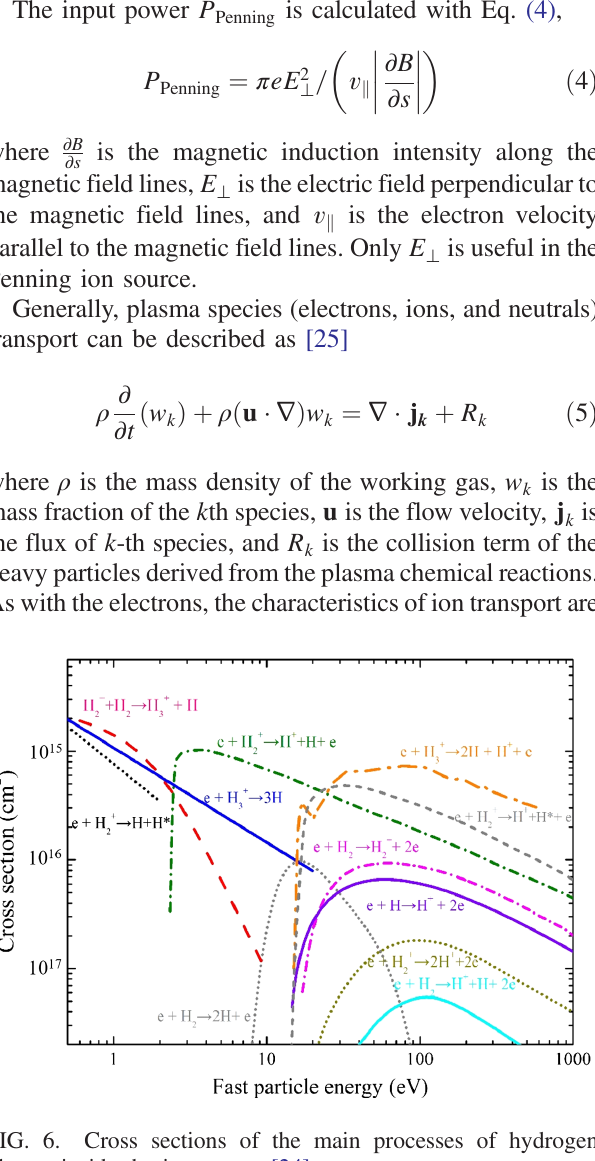
FIG. 6. Cross sections of the main processes of hydrogen plasma inside the ion source